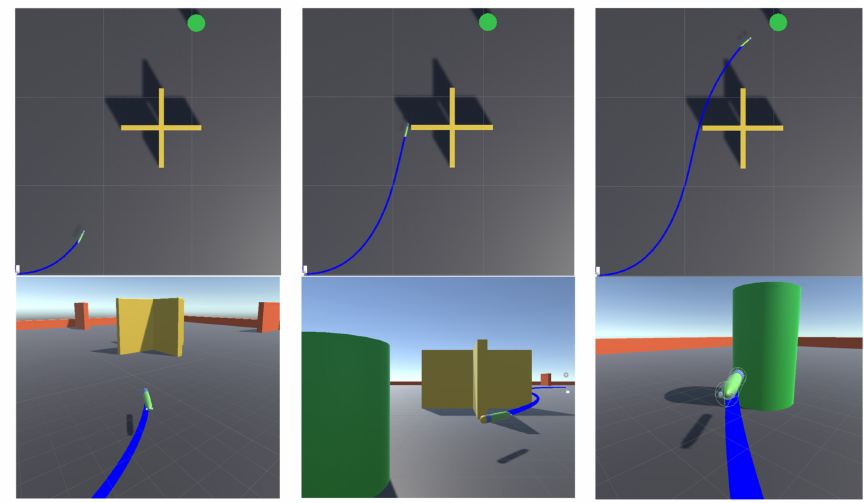
Figure 12. AUV local